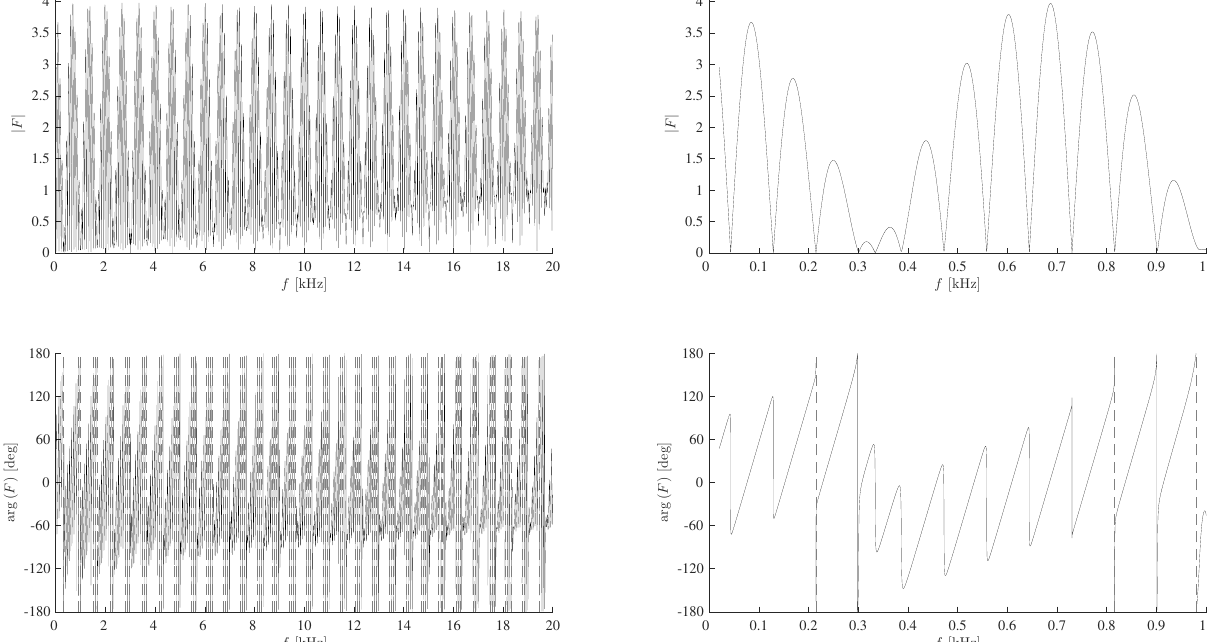
Figure 4: The same as Figure 3, but for a modified observer at the position ( a , b ) = (2, 6) m